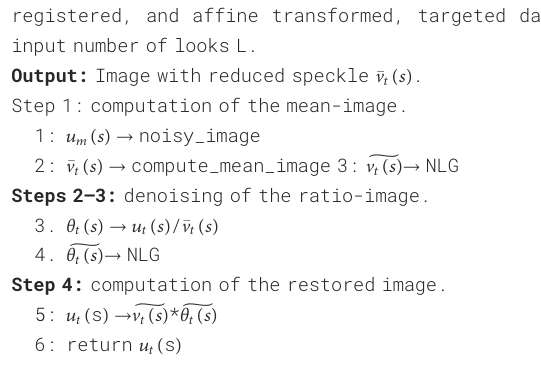
Algorithm 1. Non-local multi-temporal fi ltering algorithm ( NLG- MulSAR ).